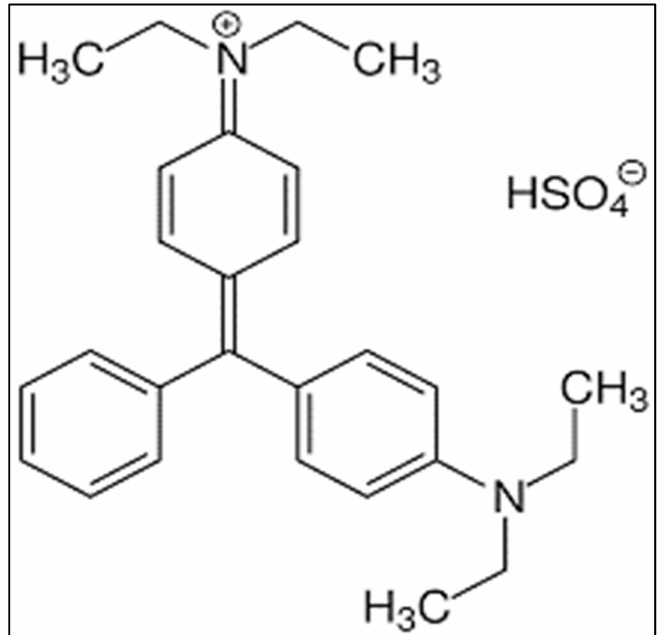
Figure 1. Brilliant green atomic